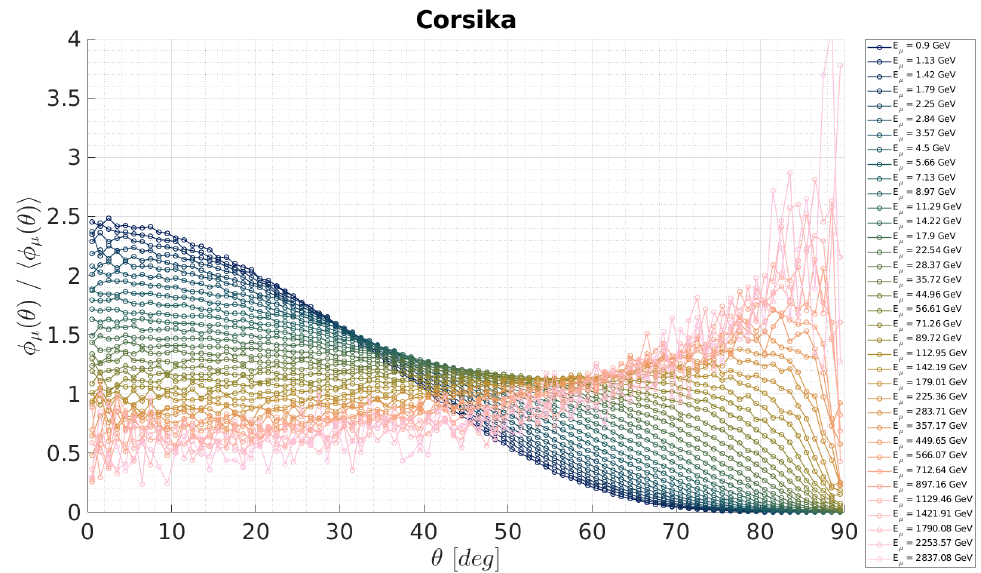
Figure 6. Differential relative muon fluxes (Flux/Mean Flux) simulated with CORSIKA and plotted as a function of the zenith angle and for several muon energy levels (different